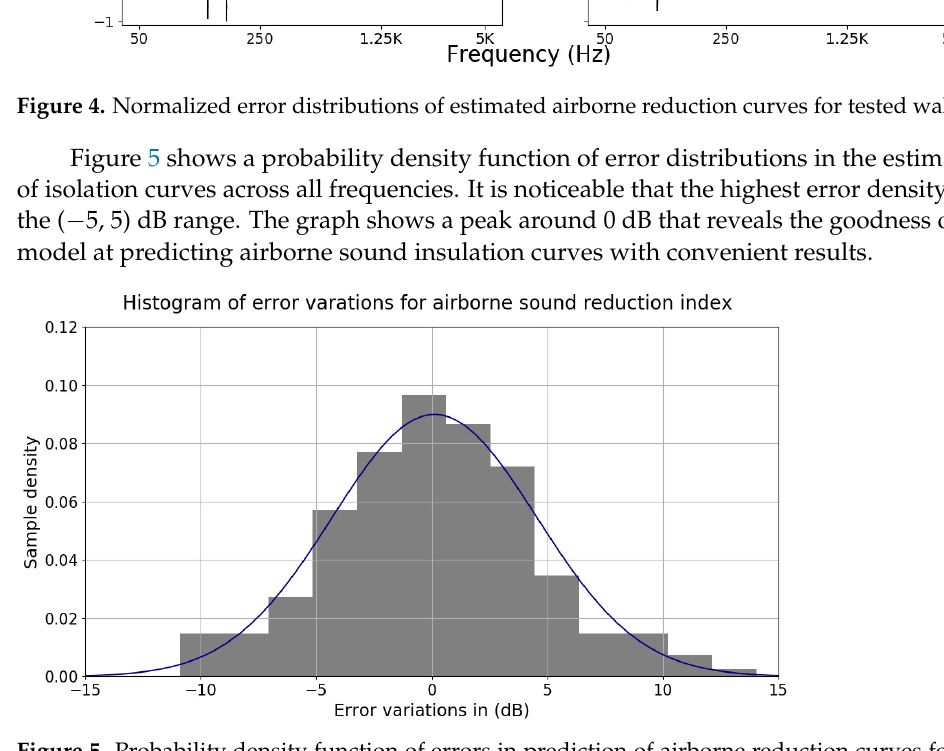
Figure 5. Probability density function of errors in prediction of airborne reduction curves for test façades in frequency range (50 Hz–5